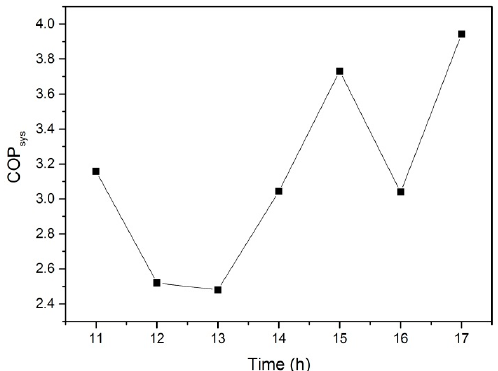
Figure 10. System COP over time.